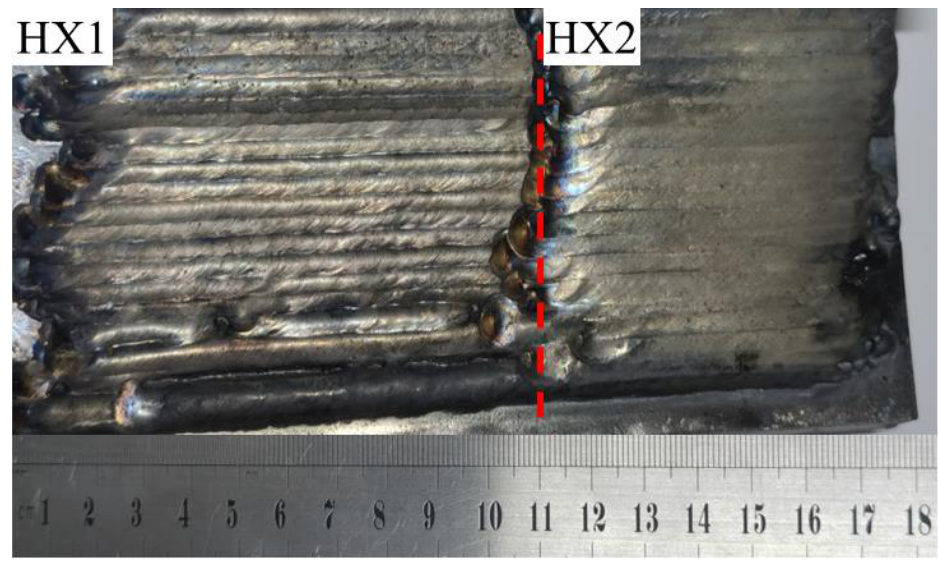
Figure 2. The surface appearance of CoCrFeNiSiMoW coating after plasma-arc surfacing welding. HX1 is a one-layer coating, and HX2 is a two-layer coating.